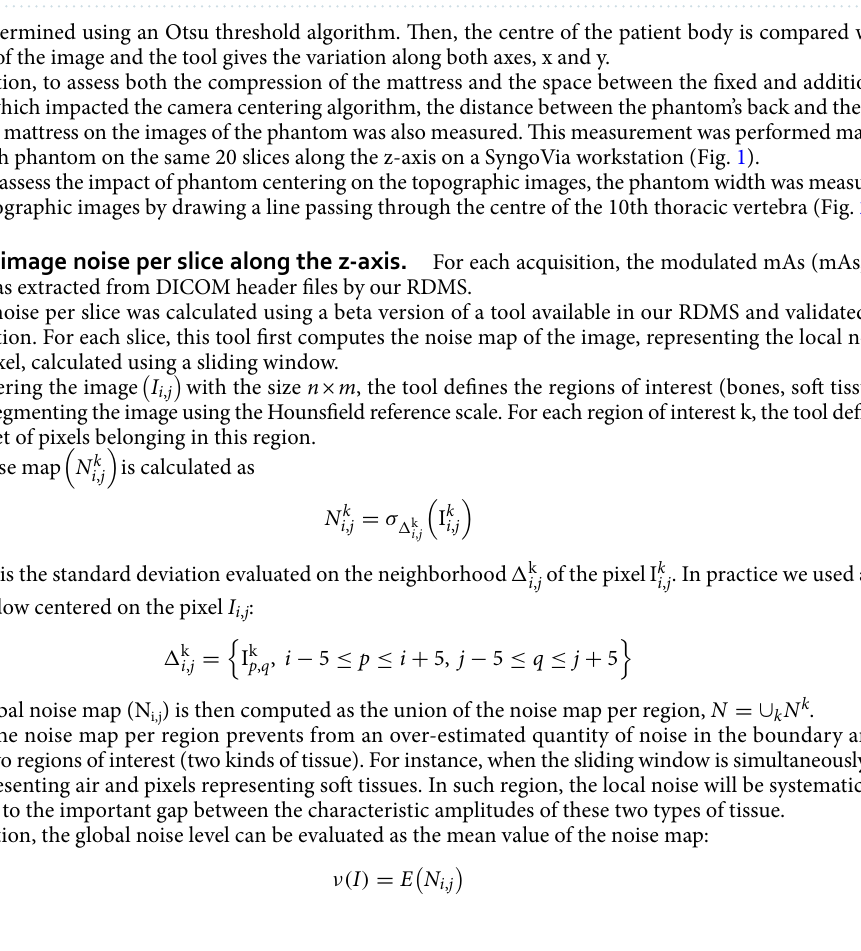
Figure 1. Images of the phantom at the level of the thorax after centering the phantom automatically with the 3D camera and then manually without and with the three additional mattresses (window level: − 500 HU and width: 1500 HU). The red dotted line represents the centre of the field of